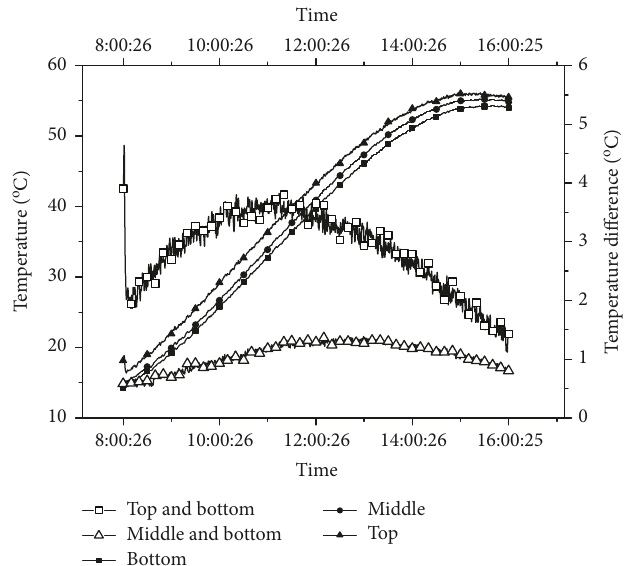
Figure 6: Variations in the bottom, middle, and top temperatures of the LT evaporation section and the temperature di ff erence between the top and bottom parts of the